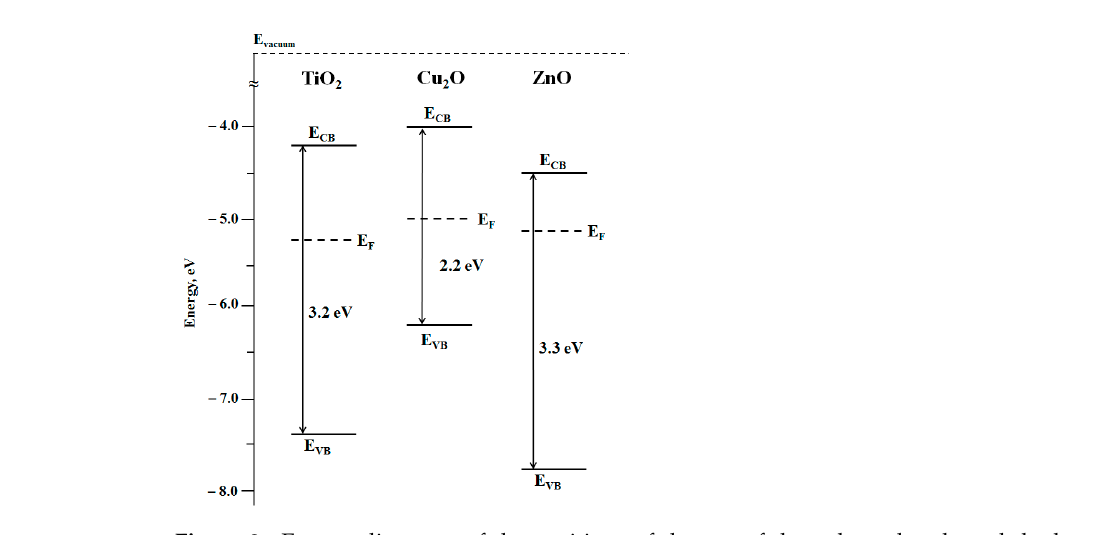
Figure 2. Energy diagrams of the positions of the top of the valence bands and the bottom of the conduction bands and Fermi level positions of the individual components of the heterostruc- tured coatings.